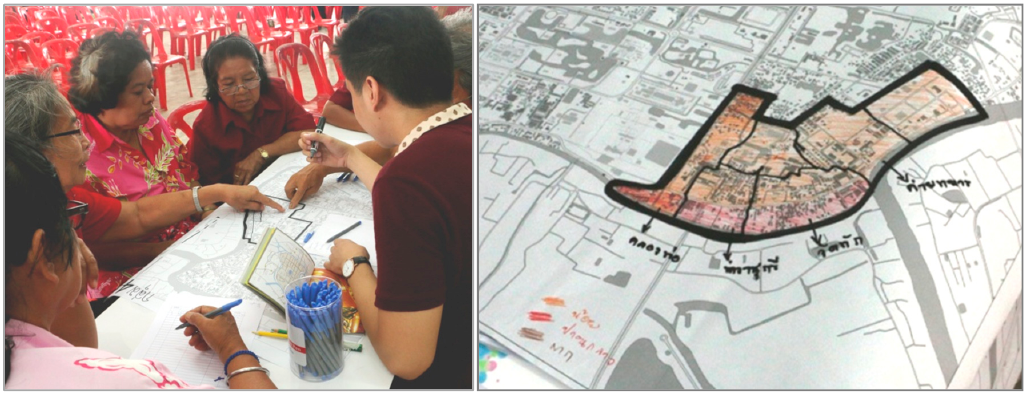
Figure 2. Flood hazard and risk perception group mapping exercise with community representatives in Ayutthaya, Thailand. Community groups were asked to produce maps and drawings with their personal experiences from flood events, i.e., a qualitative way of working (see also [21]).